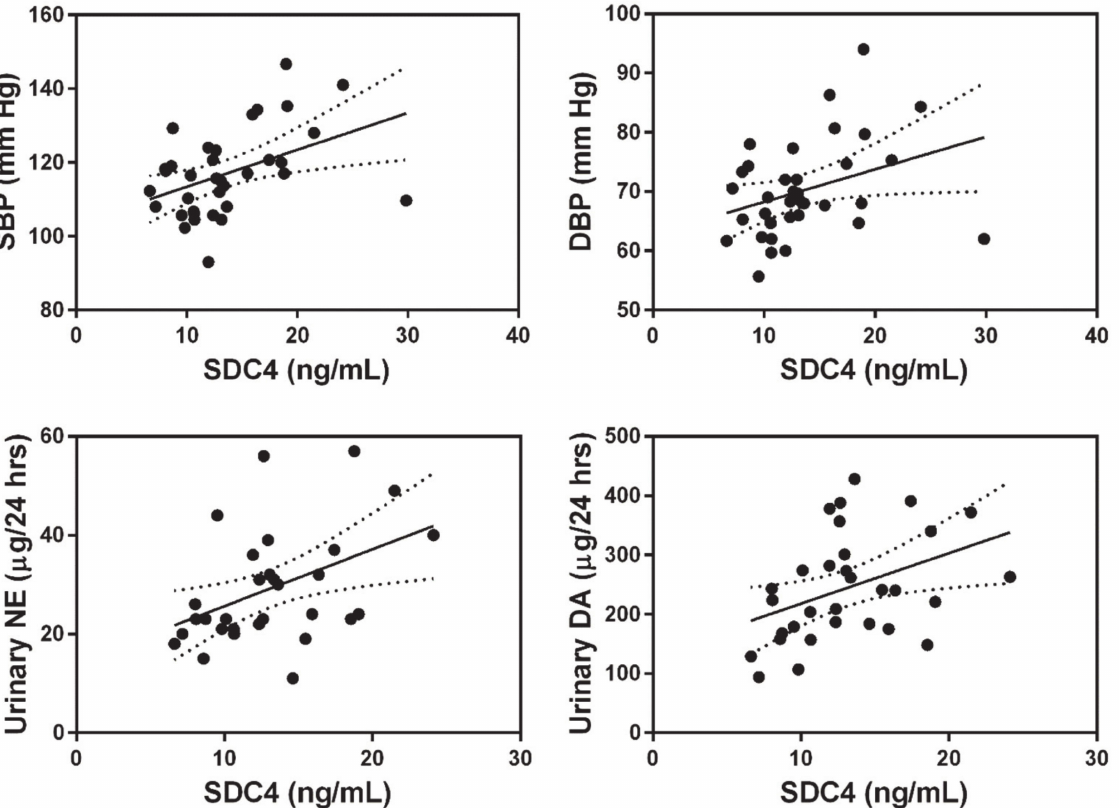
Figure 2. Serum levels of syndecan-4 (SDC4) are positively associated with blood pressure and urinary catecholamine concentrations. Scatterplots of the association between SDC4 ( n = 37) and systolic blood pressure (SBP) ( n = 37), diastolic blood pressure (DBP) ( n = 37), urinary norepinephrine (NE) levels ( n = 33), and urinary dopamine (DA) levels ( n = 33). Shown in the plots is the 95% confidence band of the best-fit